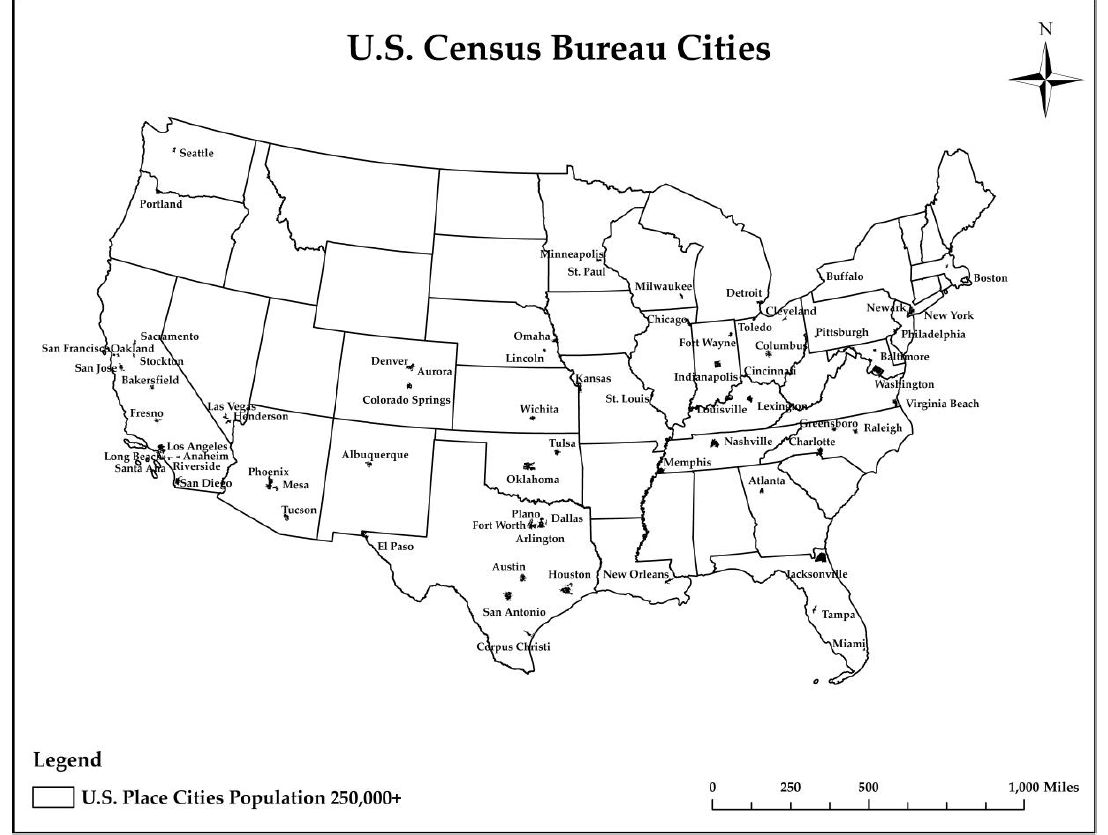
Figure 1. 72 United States (U.S.) cities that have a population greater than or equal to 250,000 in